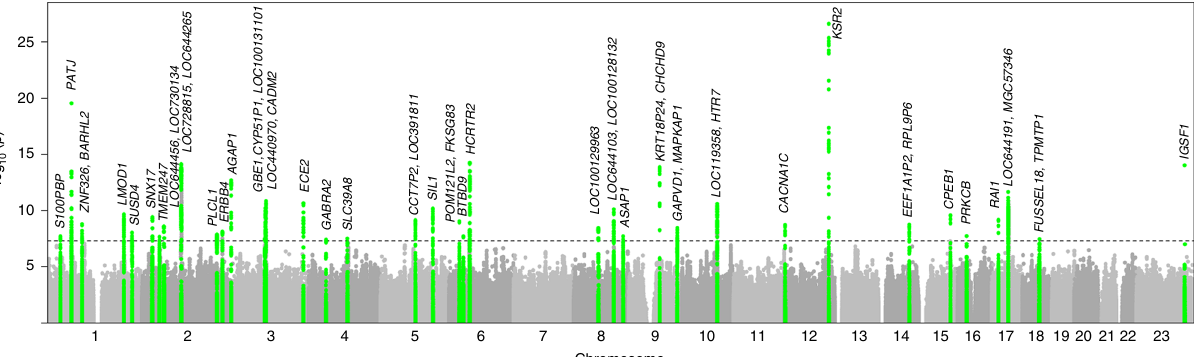
Fig. 1 Manhattan plot for genome-wide association analysis of self-reported daytime sleepiness. Dotted line indicates genome-wide signi fi cance. Genetic association signals are highlighted in green and annotated with the